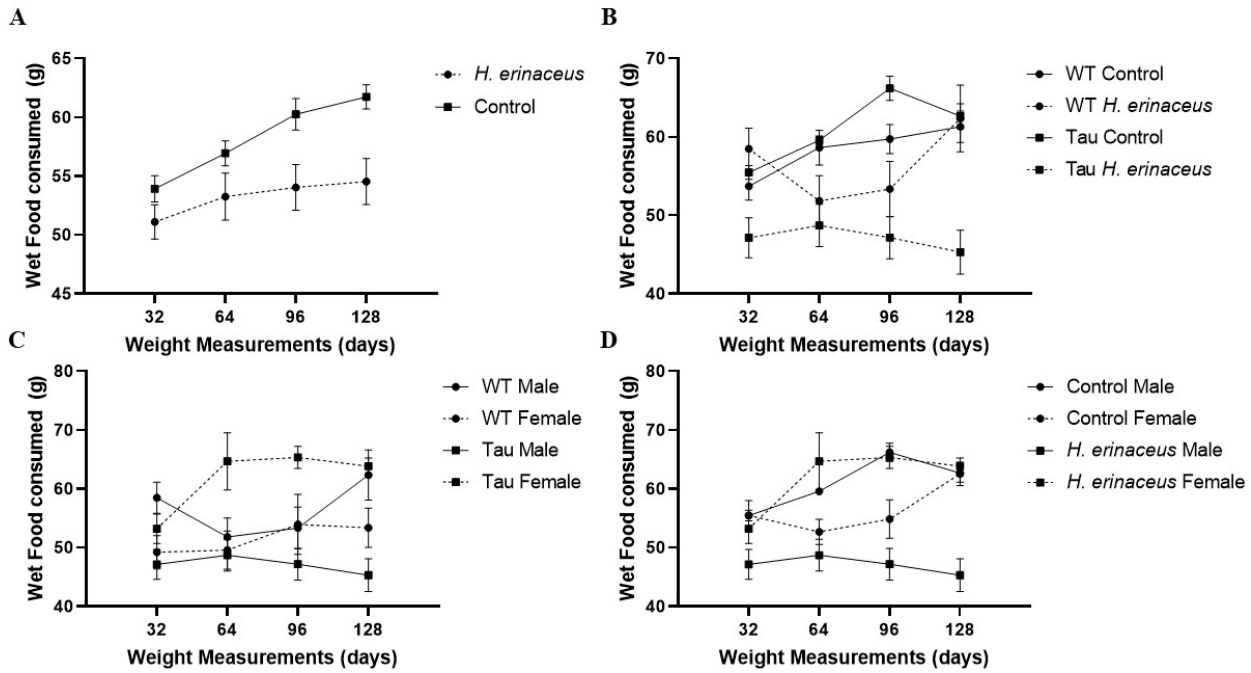
Figure 2. Wet food consumption over time. ( A ) Mice on the control diet (no H. erinaceus ) ate more food than those given H. erinaceus . ( B ) Male control diet mice ate more wet food at day 64 ( p < 0.01), 96 ( p < 0.001), and 128 ( p < 0.01) than male mushroom mice. Tau control mice ate significantly more wet food than tau mushroom mice; only male mice graphed. ( C ) Female mice ate more than male mice at 64 ( p < 0.05) and 96 ( p < 0.01) days. Female tau mice ate significantly more than male tau mice, p < 0.001. Tau female mice ate significantly more wet food than WT female mice ( p = 0.001). WT male mice ate significantly more wet food than Tau male mice, p = 0.001; only H. erinaceus diet condition graphed. ( D ) Tau control mice ate more than tau mushroom mice at day 32 ( p < 0.05) and 128 ( p < 0.01). Female mice ate significantly more than male mice, p < 0.05. Male control mice ate significantly more wet food than male mushroom mice, p < 0.001. Female mushroom mice ate significantly more wet food than male mushroom mice, p < 0.001; only tau mice graphed. Error bars represent mean ±